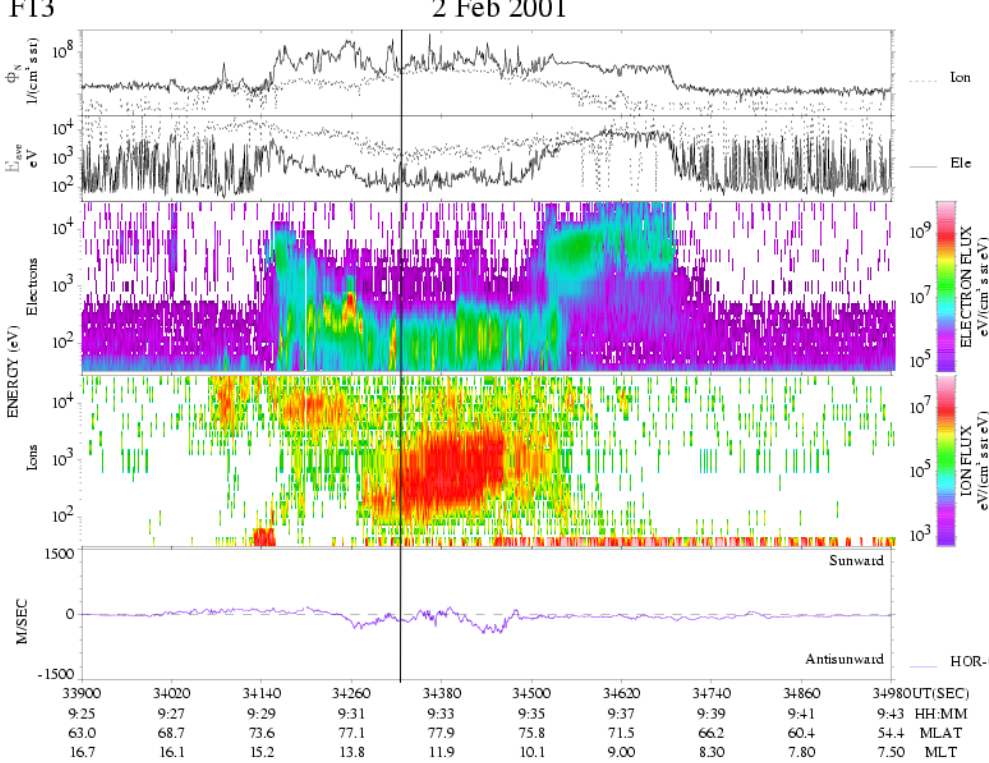
Fig. 8. DMSP data from the SSJ/4 instrument between 09:25 and 09:43UT on 2February2001. The entry of the spacecraft in the field-of- view of the ESR is marked with a black vertical